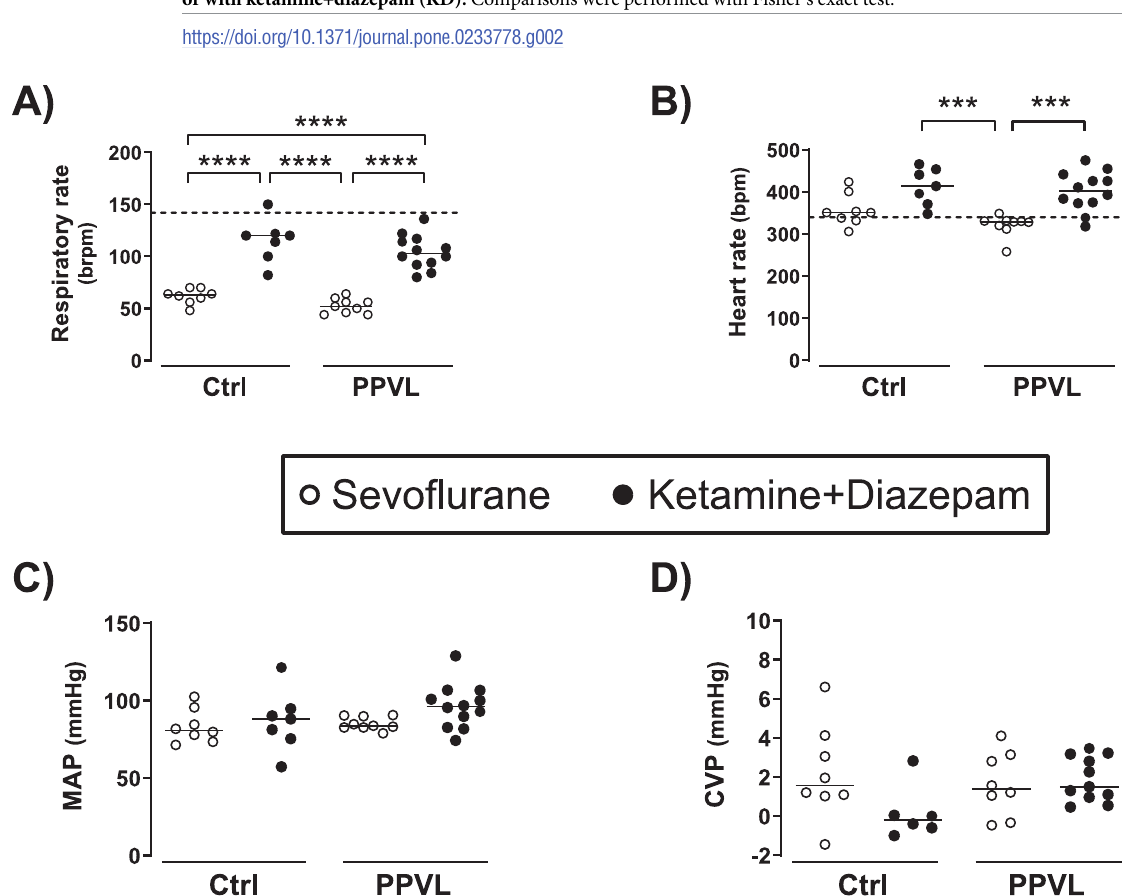
Fig 3. A) Respiratory rate, B) heart rate, C) mean arterial pressure (MAP), and D) central venous pressure (CVP) in normal rats (Ctrl) and rats with partial portal vein ligation (PPVL) anesthetized with sevoflurane (Sevo) or ketamine+diazepam (KD). Median [IQR] of Ctrl+Sevo vs. Ctrl+KD vs. PPVL+Sevo vs. PPVL+KD for: Respiratory rate (brpm) : 63 [57, 69] vs. 120 [100, 122] vs. 52 [45, 58] vs. 103 [93, 116]; Heart rate (bpm) : 351 [334, 389] vs. 414 [371, 454] vs. 329 [316, 332] vs. 402 [374, 438]; MAP (mmHg) : 81 [75, 93] vs. 88 [76, 95] vs. 84 [83, 90] vs. 96 [85, 105]; CVP (mmHg) : 1.6 [1.0, 3.9] vs. -0.2 [-0.7, 0.7] vs. 1.4 [0.0, 3.1] vs. 1.5 [1.0, 3.2]. ��� p < 0.001, ���� p < 0.0001 One- way ANOVA with Tukey’s post-hoc tests. The line and dots represent the median and individual rat values, respectively. The dash lines represent the mean respiratory rate (142 brpm) and heart rate (340 bpm) reported in normal awake rats in prior studies [21].